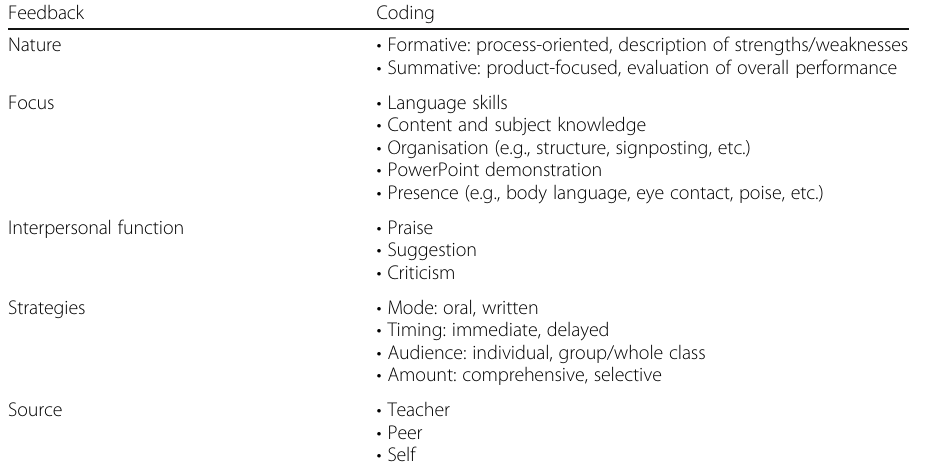
Table 1 Coding scheme of teacher beliefs Feedback Coding